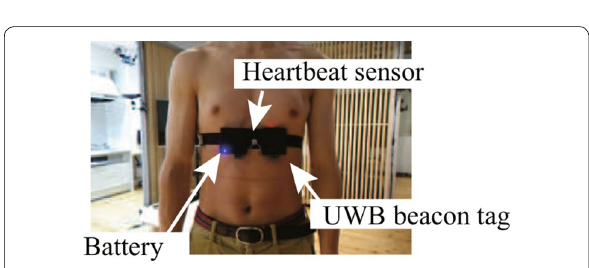
Fig. 8 Heartbeat sensor (WHS-1) and UWB beacon tag